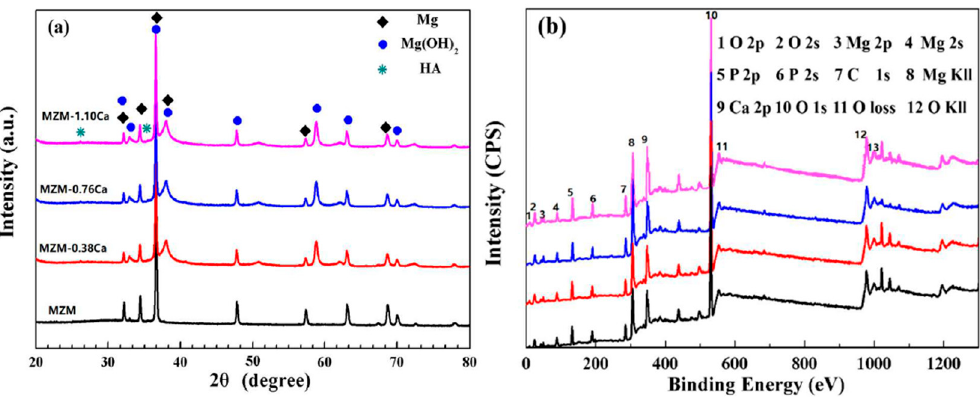
Figure 8. XRD and XPS spectrum of corrosion products of MZM-xCa alloys: ( a ) XRD; and ( b ) XPS.